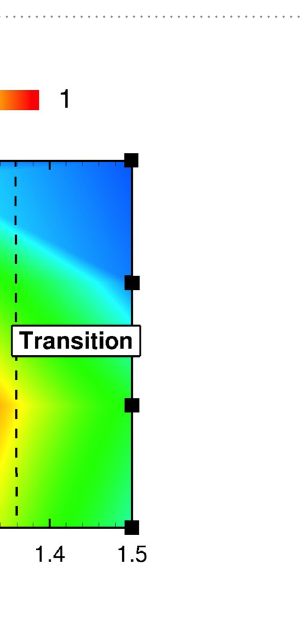
Figure 6. Snapshots of the flow of MPs and RBCs for ( a ) Ca = 0.05, and ( b ) 0.4 in capillary with a diameter of D = 8 μ m. See also Supplemental Movie S7.